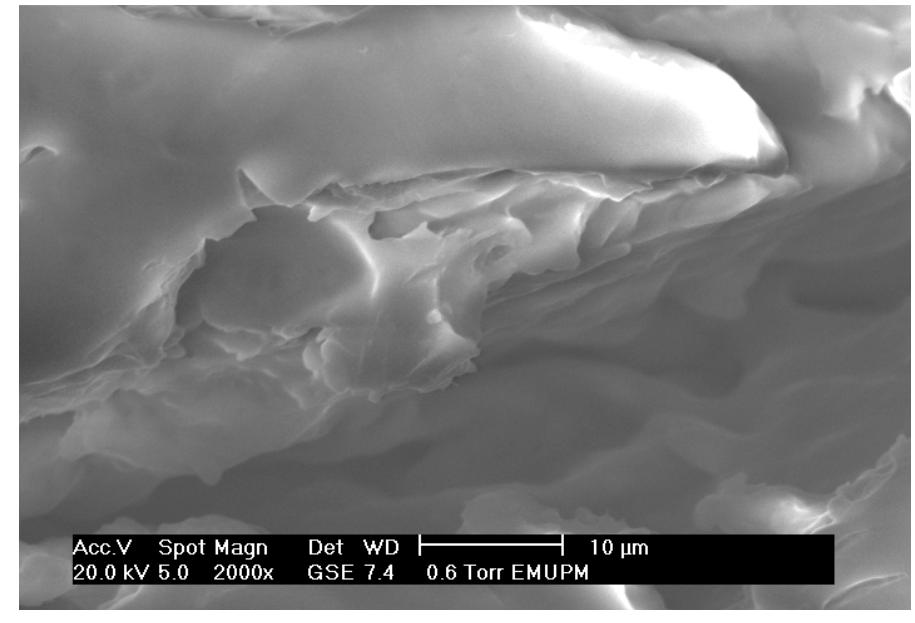
Figure 7. Scanning electron micrograph (SEM) of encapsulated